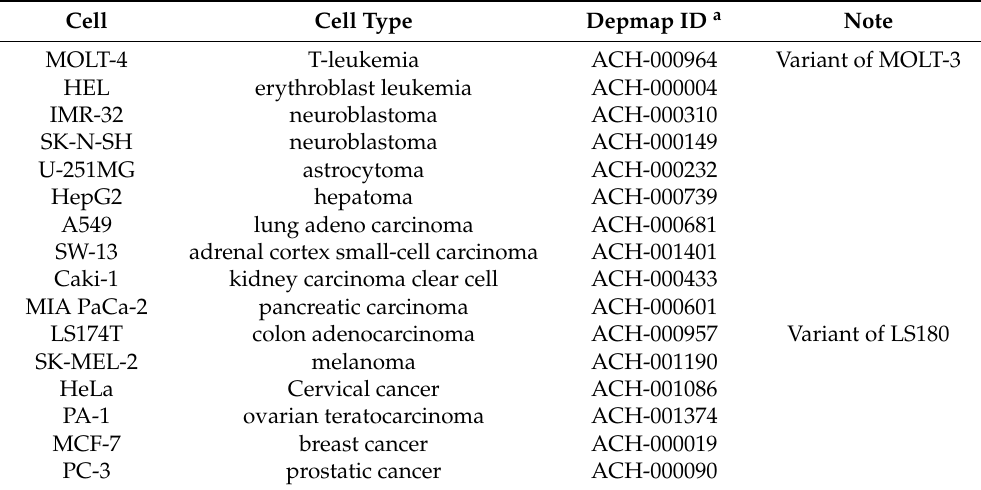
Table 1. Human cancer cell line used in this